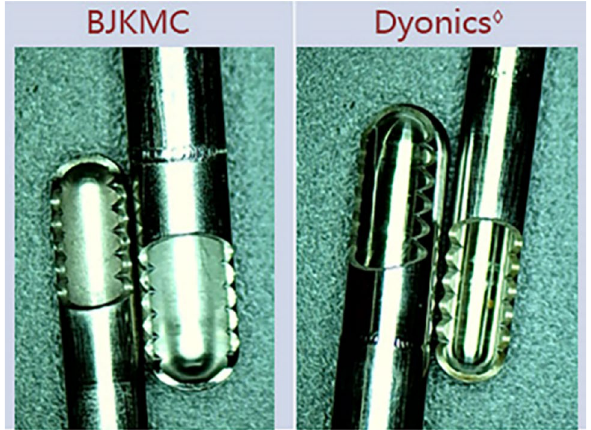
Figure 5. The double serrated blade (BJKMC) and the Incisor ◊ Plus Blade (Dyonics ◊ ).